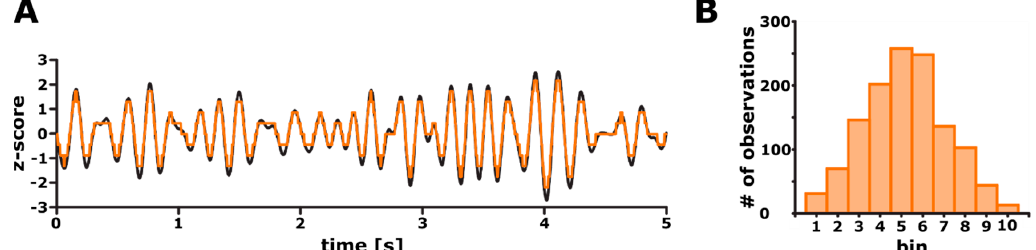
Figure A3. Example for the binning of the LFP amplitudes as used for the calculation of the mutual information. ( A ) Five seconds of normalized LFP recorded from the cortex, filtered to the 4–8 Hz range and down sampled to 250 Hz (black) and a binned representation of the signal using 10 equally spaced bins (orange). ( B ) Corresponding histogram of the binned amplitudes. LFP: local field potential.